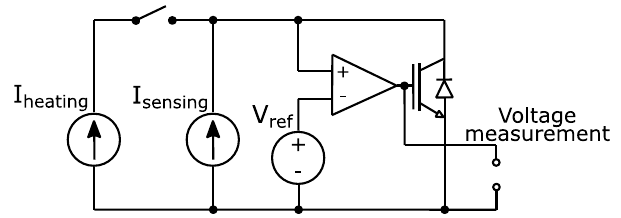
Figure 6. Regulated V CE mode power-cycling setup.